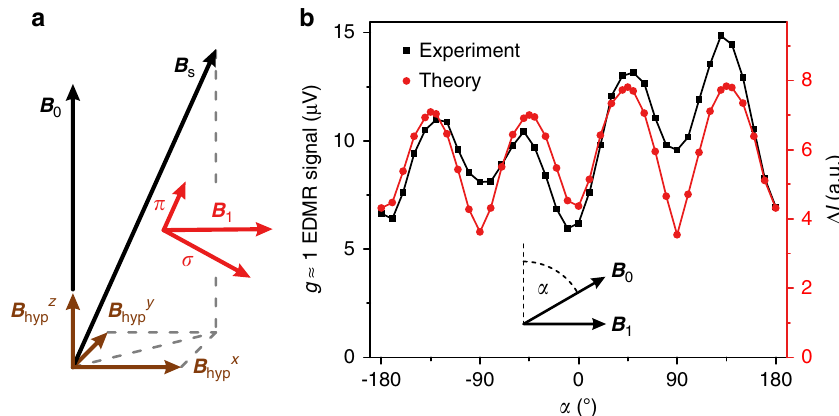
Fig. 4 Intuitive rationalization of the two-photon transition and the angular dependence of the two-photon g ≈ 1 EDMR signal. a Sketch of the magnetic- fi eld con fi guration acting on a spin within a spin pair. Oscillating magnetic- fi eld components (red arrows) parallel ( π ) and perpendicular ( σ ) to the effective local quantizing static magnetic fi eld B s arise from the decomposition of B 1 with respect to the total static magnetic fi eld that results from the superposition of B 0 and B hyp . b Angular dependence of the two-photon EDMR resonance measured at f = 22 MHz (black) for the d-MEH-PPV devices. The experimental results match the sin2 α dependence predicted by theory (red). Lines are a guide to the